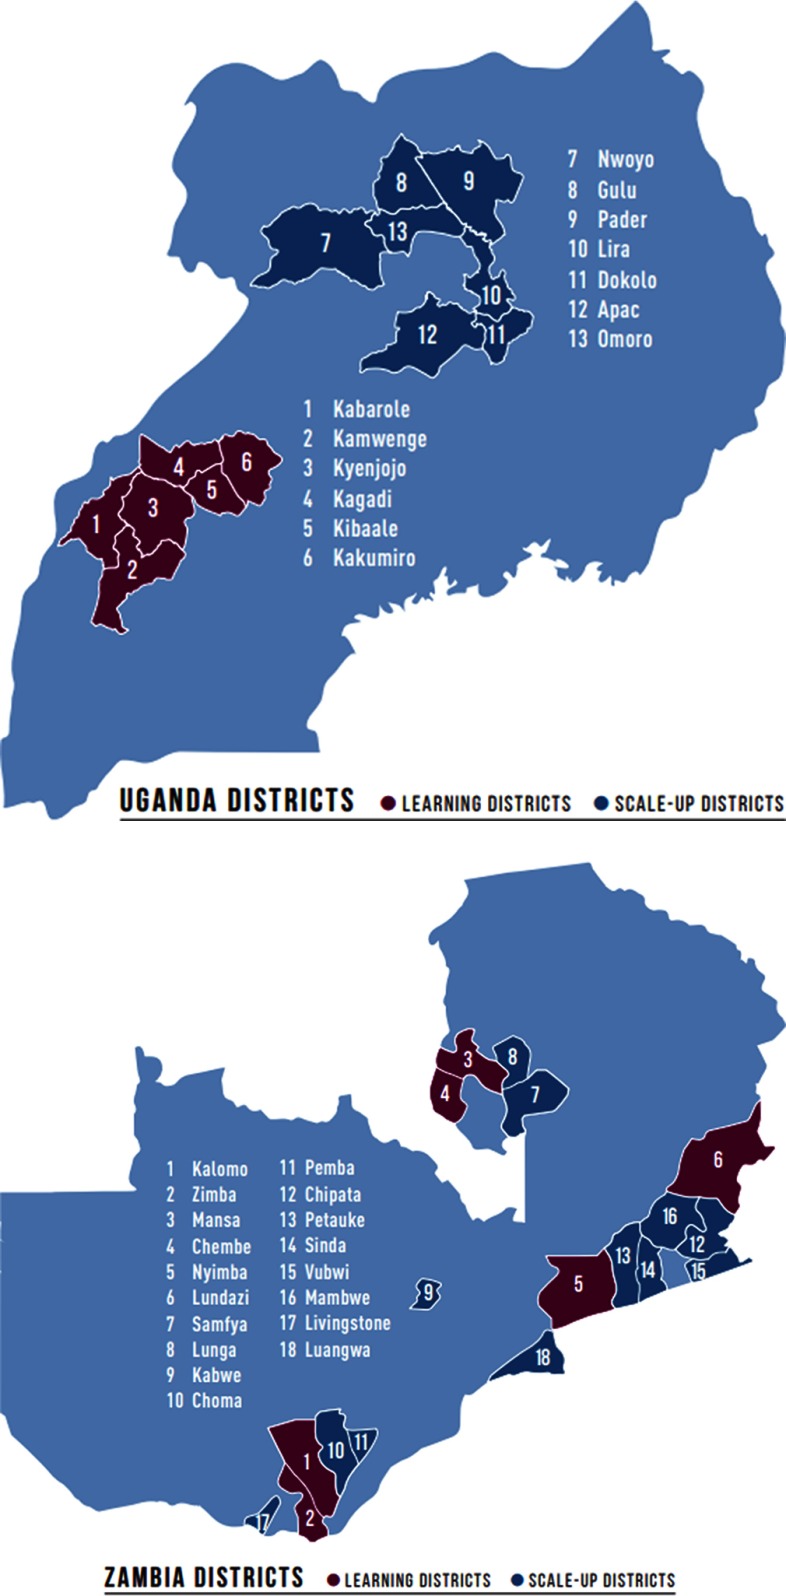
Saving Mothers, Giving Life-Designated Learning and Scale-Up Districts in Uganda and ZambiaSource: Adapted from Saving Mothers, Giving Life.57